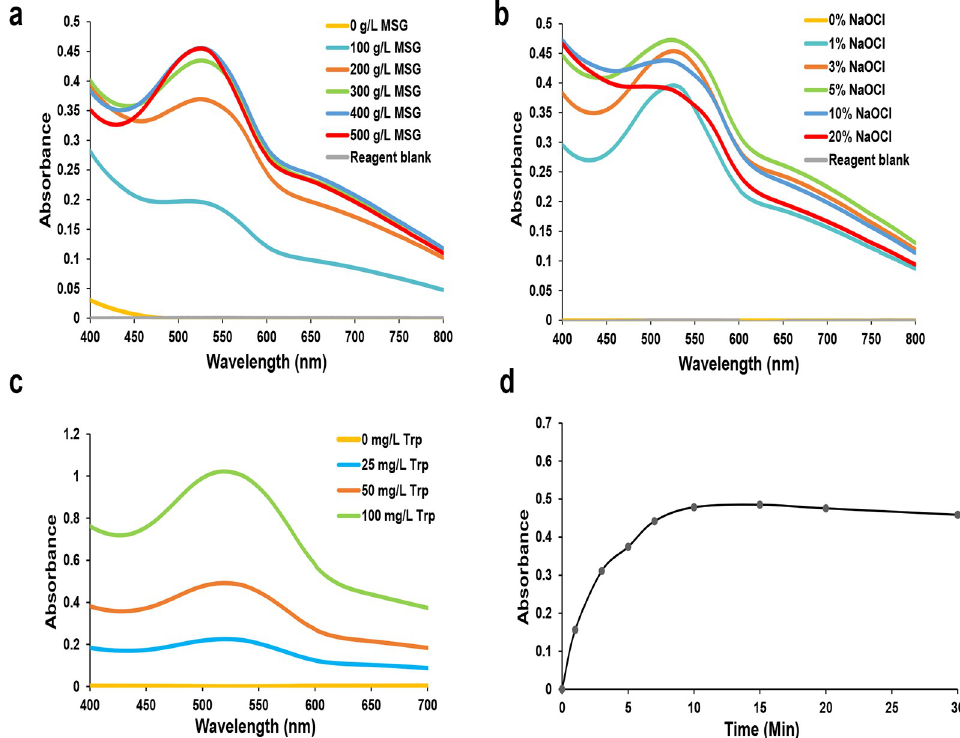
Fig 3. Optical absorption spectra versus concentration of additive reagent. (a) Absorption spectra for 50 mg/L of Trp and different concentrations of MSG (100, 200, 300, 400, and 500 g/L) with the addition of 10% HCl and 3% NaOCl � 5H 2 O. Reagent blank (0 mg/L of Trp with 400 g/L of MSG, 10% HCl, and 3% NaOCl � 5H 2 O). (b) Absorption spectra for 50 mg/L of Trp with 400g/L of MSG, 10% HCl, and several concentrations of NaOCl � 5H 2 O (1, 3, 5, 10, and 20%). Reagent blank (0 mg/L of Trp with 400 g/L of MSG, 10% HCl, and 3% NaOCl � 5H 2 O). (c) Absorption spectra for various concentrations of Trp (0, 25, 50, and 100 mg/L) after adding 400 g/L of MSG, 10% HCl, and 5% NaOCl � 5H 2 O. (d) Change in the absorption intensity (525 nm) of Trp solution (50 mg/L) over time (1, 3, 5, 7, 10, 15, 20, and 30 min), after adding 400 g/L of MSG, 10% HCl, and 5% NaOCl � 5H 2 O.